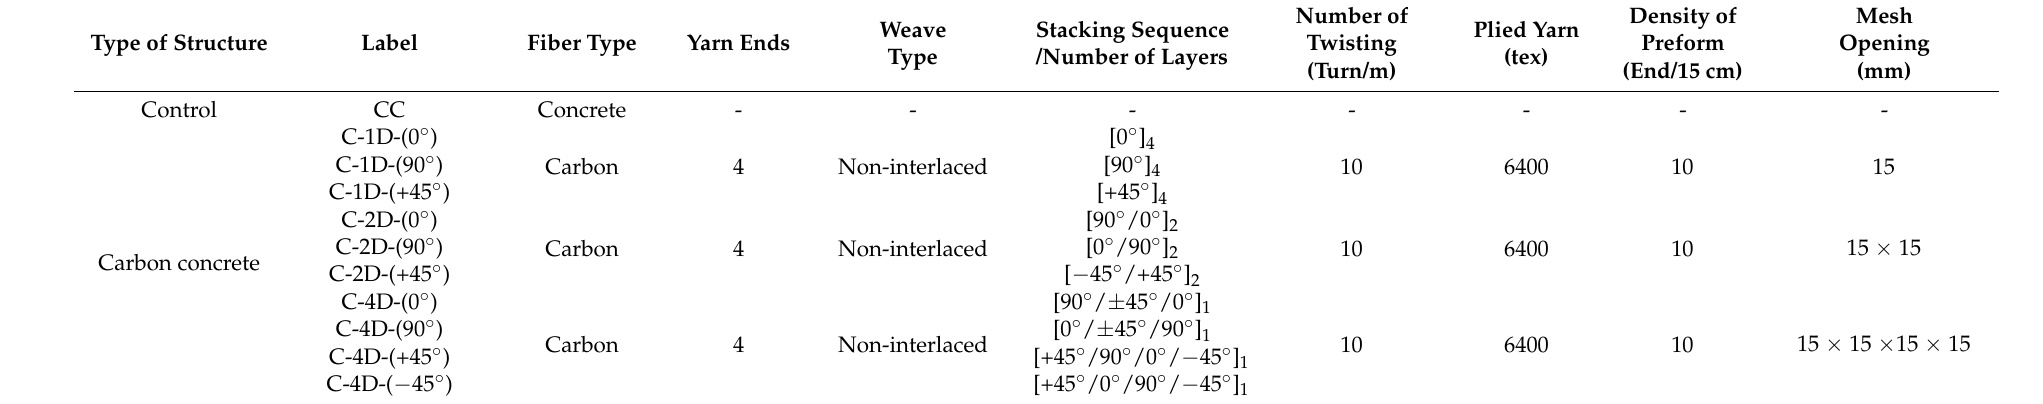
Table 2. Specifications of multiaxis 3D concrete structures for the concrete